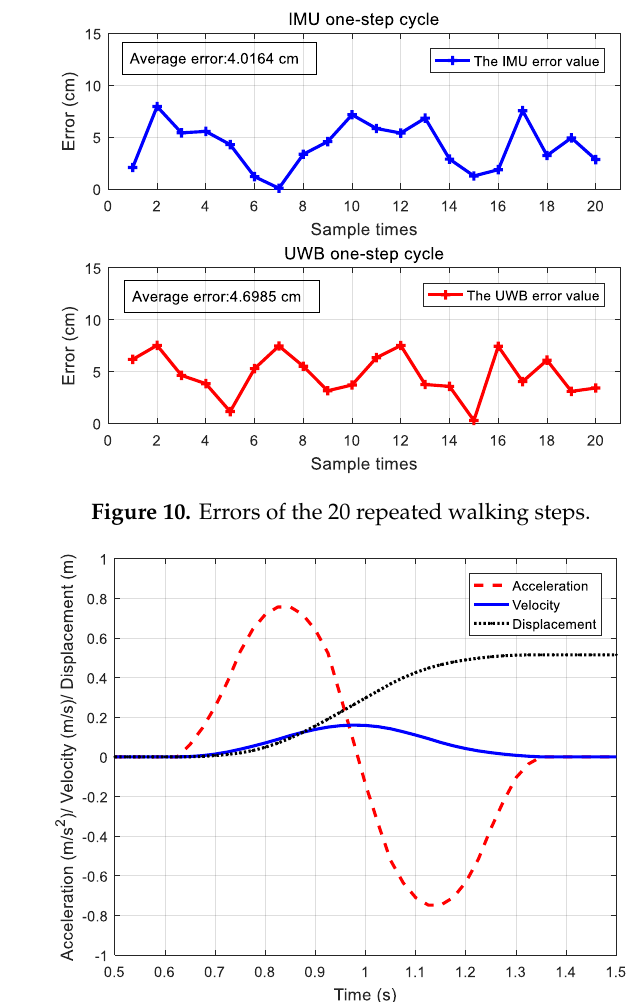
Sensors 2020 , 20 , x FOR PEER REVIEW Figure 9. Displacement of one-step walking. Figure 9. Displacement of one-step walking.